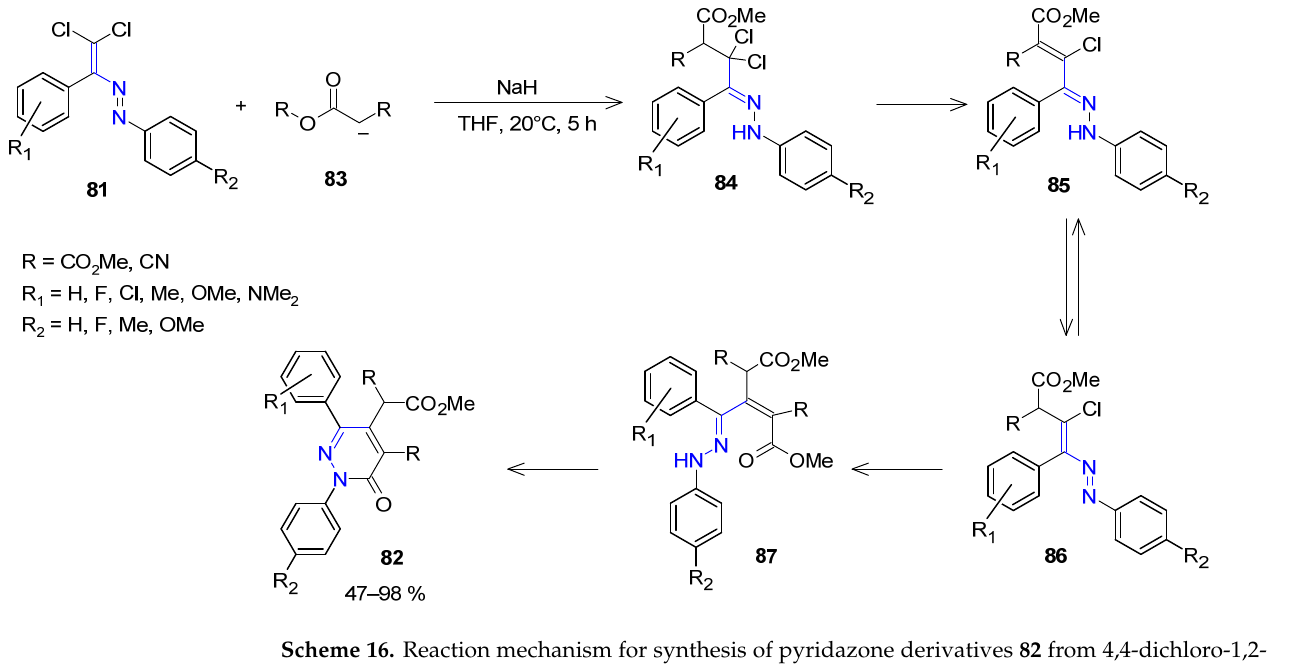
Scheme 16. Reaction mechanism for synthesis of pyridazone derivatives 82 from 4,4-dichloro-1,2-